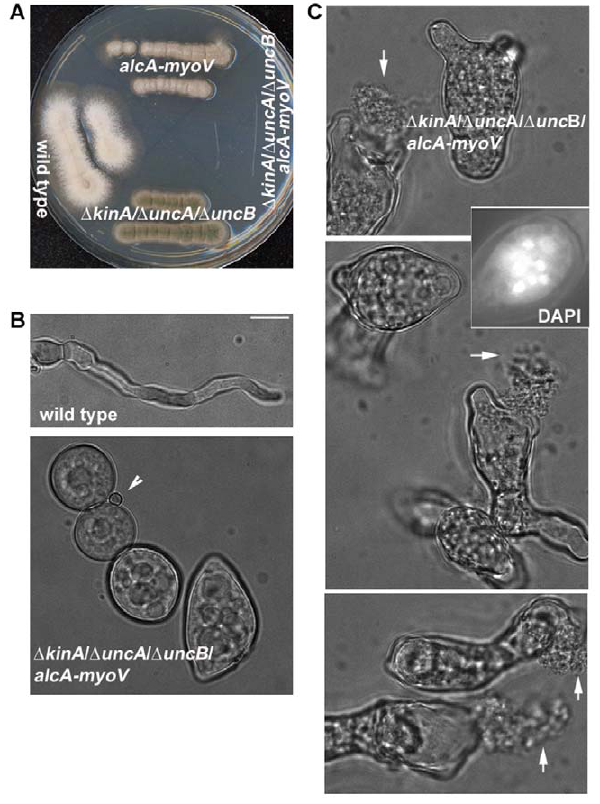
Figure 6. KINA is more critical than UNCA in the absence of MYOV. (A) Polarized growth occurs in both the D uncA/alcA-myoV and D kinA/alcA-myoV mutants. All strains were grown in YUU liquid medium for 6.5 hours at 37 u C. All panels shown are at the same magnification. Bar, 5 m m. (B) After a 2-day incubation on a YUU plate at 37 u C, the D kinA / alcA-myoV double mutant grew dramatically more slowly than either single mutant, while the growth of D uncA / alcA-myoV double mutant was only mildly worse than that of the alcA-myoV